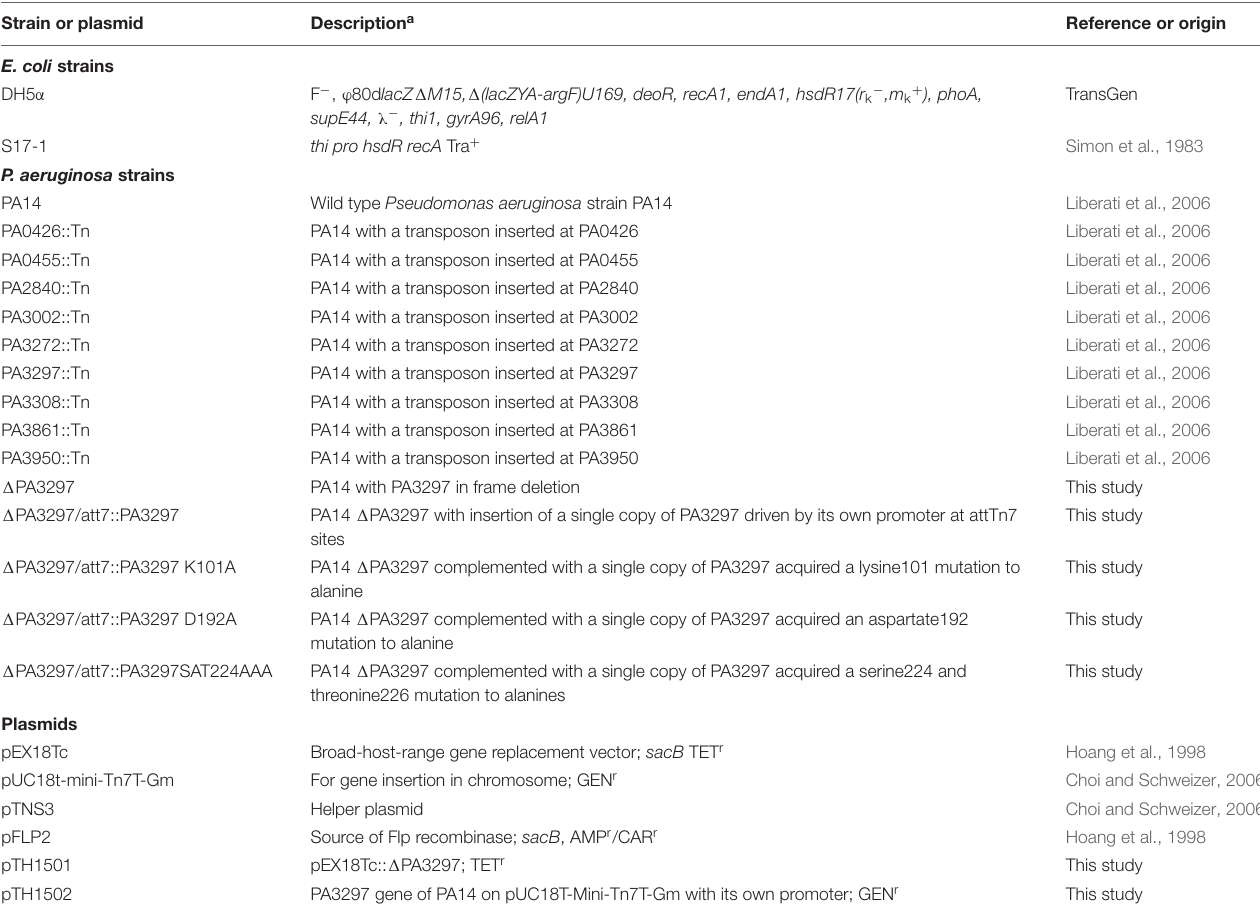
TABLE 1 | Bacterial strains and plasmids used in this